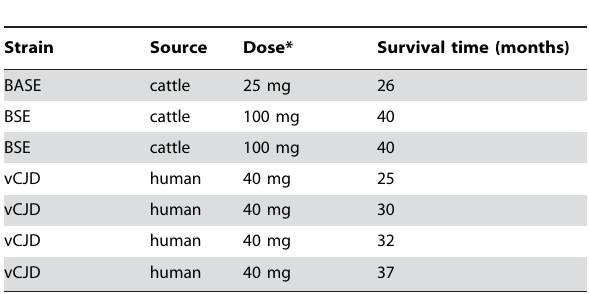
Table 1 . Survival times of macaques inoculated intracerebrally with brain homogenates from cattle with BASE or BSE, and from humans with vCJD.